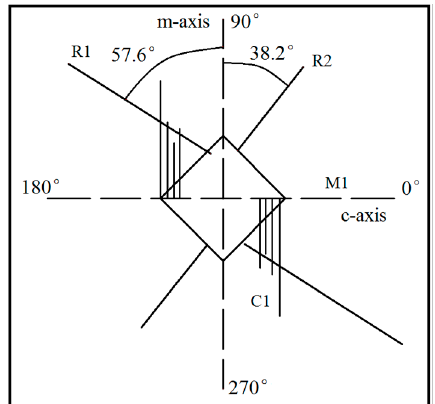
Figure 9. Schematic of the crystal axes and the relevant preferential crack systems of A-plane sapphire. Similar to A-plane sapphire, the area of the indentation on C-plane sapphire also increases correspondingly with increasing indentation depth. The cracks extend away from the center of the material and small plastic deformations can be seen clearly around the residual indentation